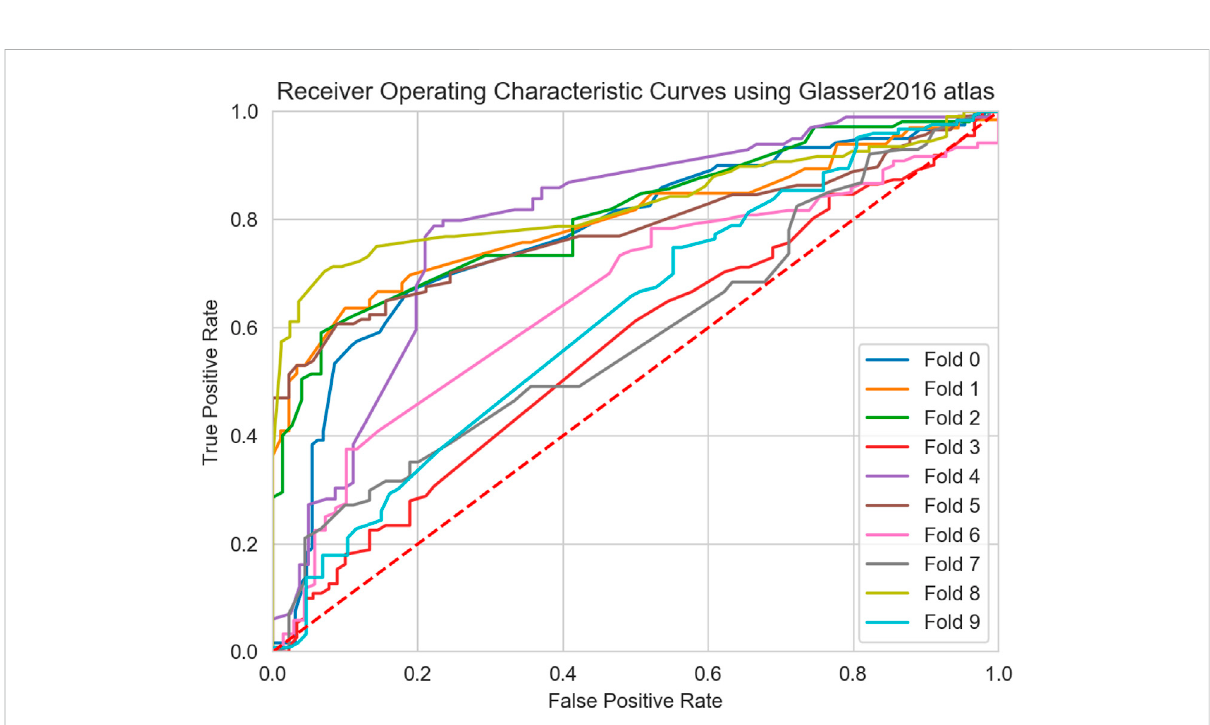
FIGURE 8 Receiver Operating Characteristic Curves (ROC) curve of the ensemble model for all 10-folds of the cross validation using the Glasser 2016 atlas.